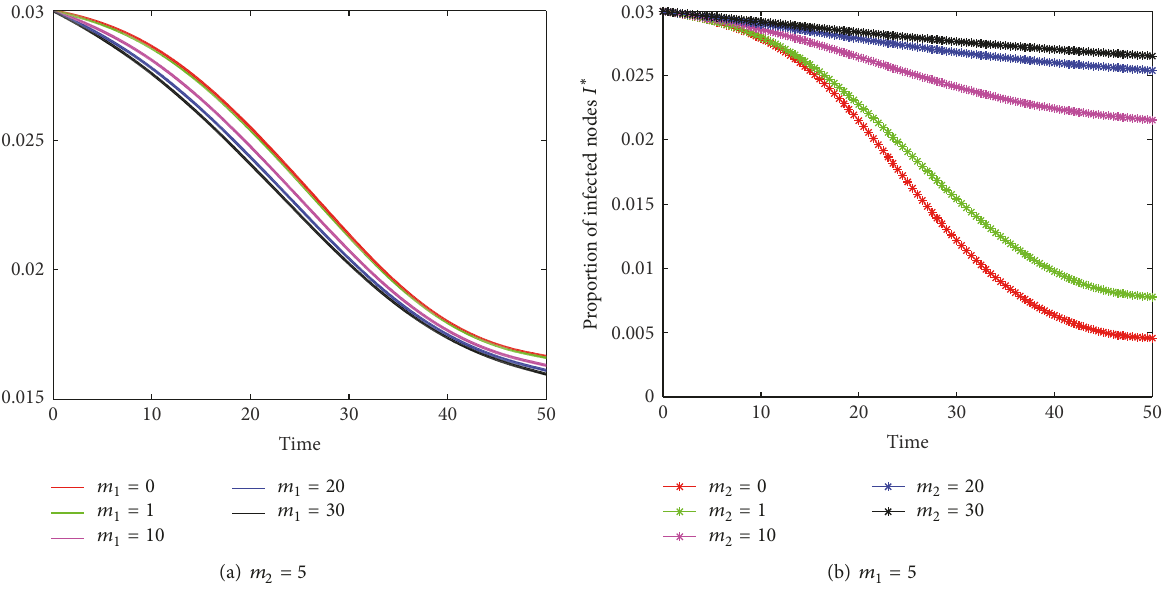
Figure 4: 𝐼 ∗ (𝑡) for different 𝑚 1 and 𝑚 2 for Example 1.